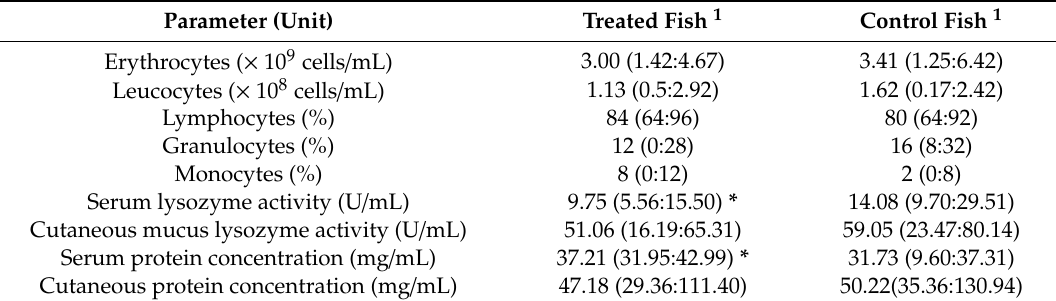
Table 2. Parameters of the innate immune response in rainbow trout when Pseudomonas fluorescens LE141 is administered to the